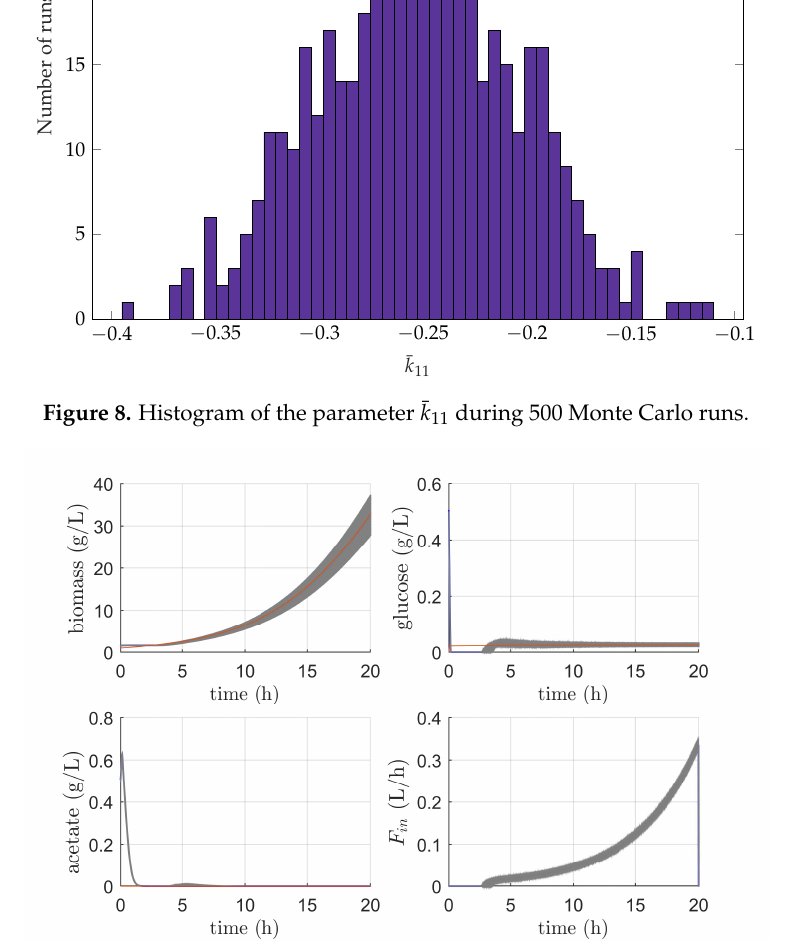
Figure 9. State variables and feed-rate evolution during 500 Monte Carlo